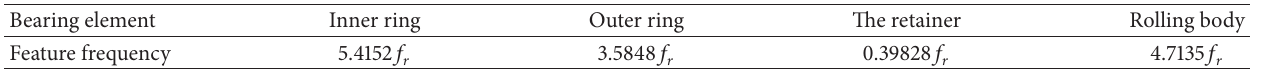
Table 2: Rolling bearing fault feature frequency of